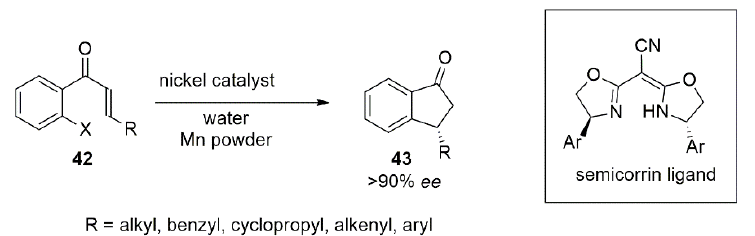
Figure 23. Stereoselective synthesis of indanones ( 43 ) through Ni-semicorrin catalyst.